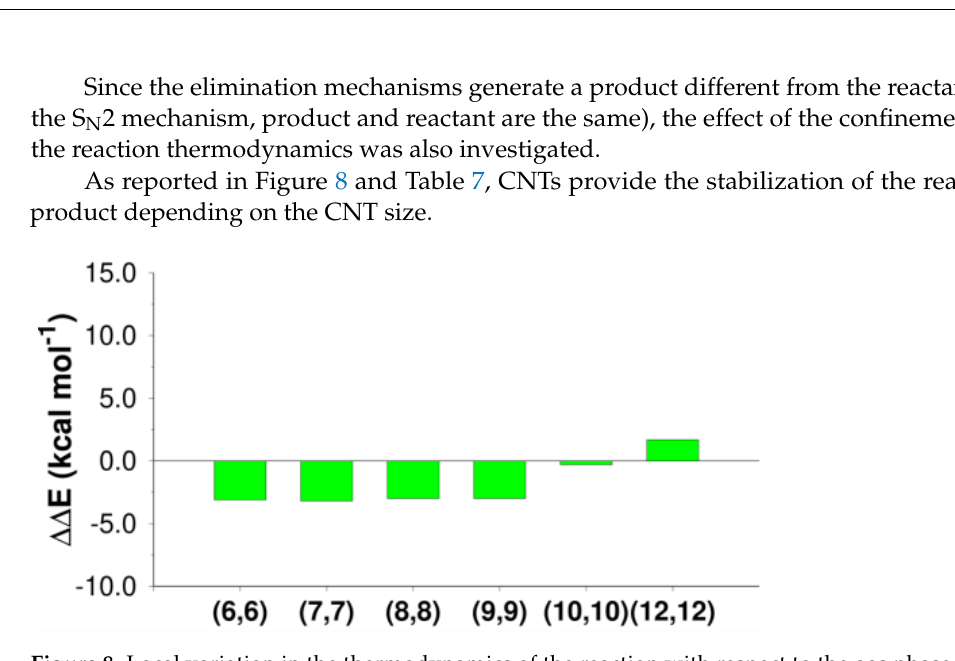
Figure 8. Local variation in the thermodynamics of the reaction with respect to the gas phase in the E2 reaction mechanism inside CNTs of different diameters. Table 7. Energy contributions (kcal mol −1 ) to the overall confinement effect on the E2 thermodynam- ics.